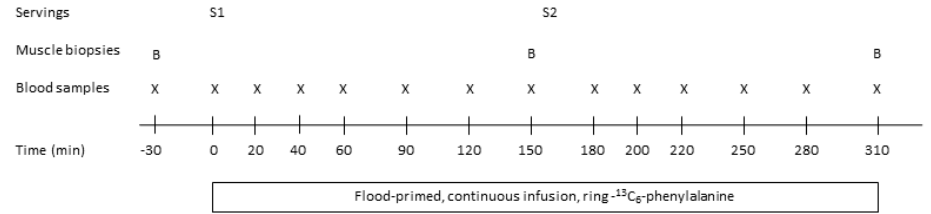
Figure 1. Experimental design. All 18 subjects completed three identical visits during the study period. B, muscle biopsy, S1, serving 1 (15 g protein); S2, serving 2 (30 g protein served with a mixed meal). Time is given in minutes (min) around time point zero (0) where the tracer infusion (flood-primed, continuous infusion) was started and S1 was provided.